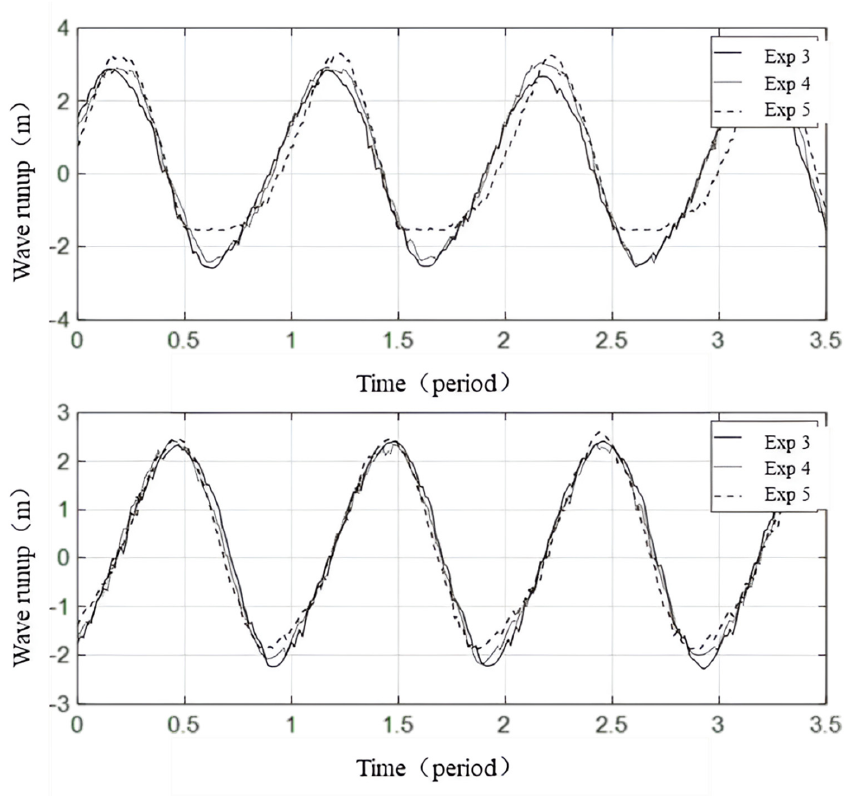
Figure 12. Wave run-up at Dazuo Seawall for Exp 3–5 of typhoons Usagi ( upper ) and Dujuan ( lower ).